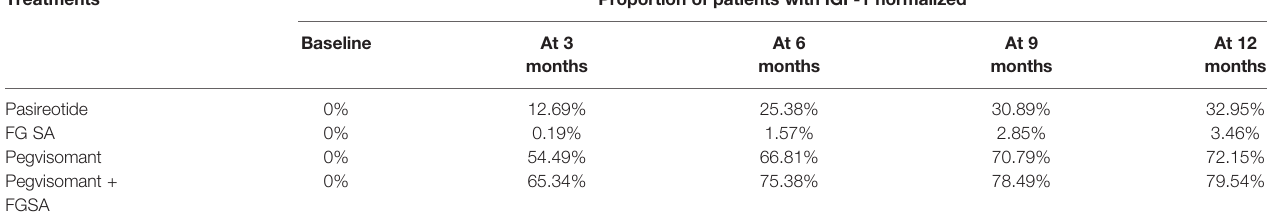
TABLE 2 | Treatment ef fi cacy used in the